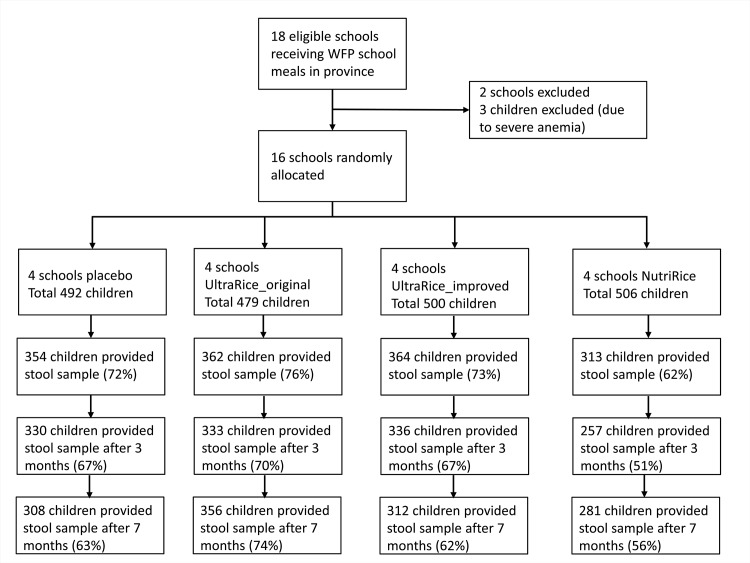
Flow chart of the study.